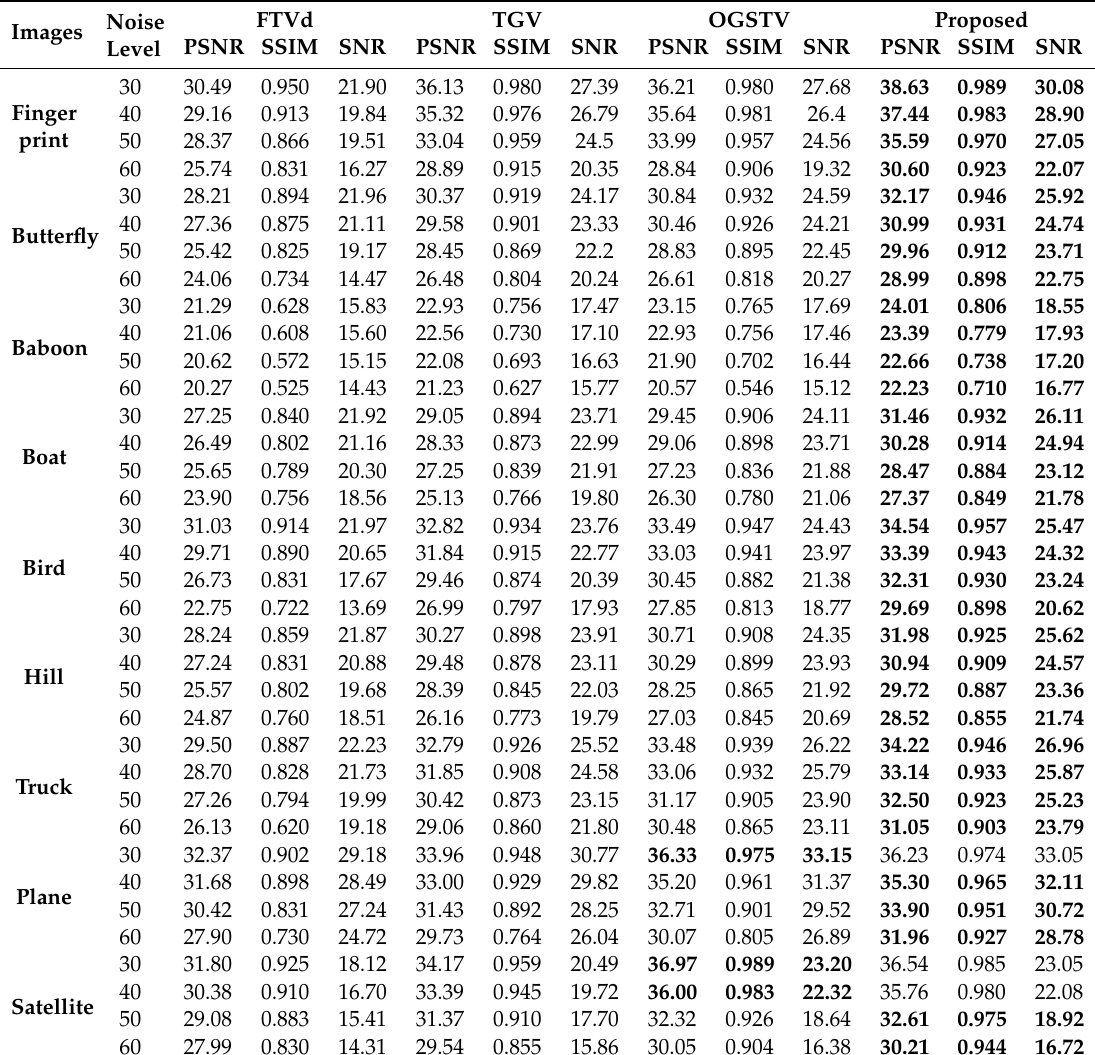
Table 2. Numerical results of PSNR (dB), structural similarity (SSIM), and SNR (dB) for the recovery